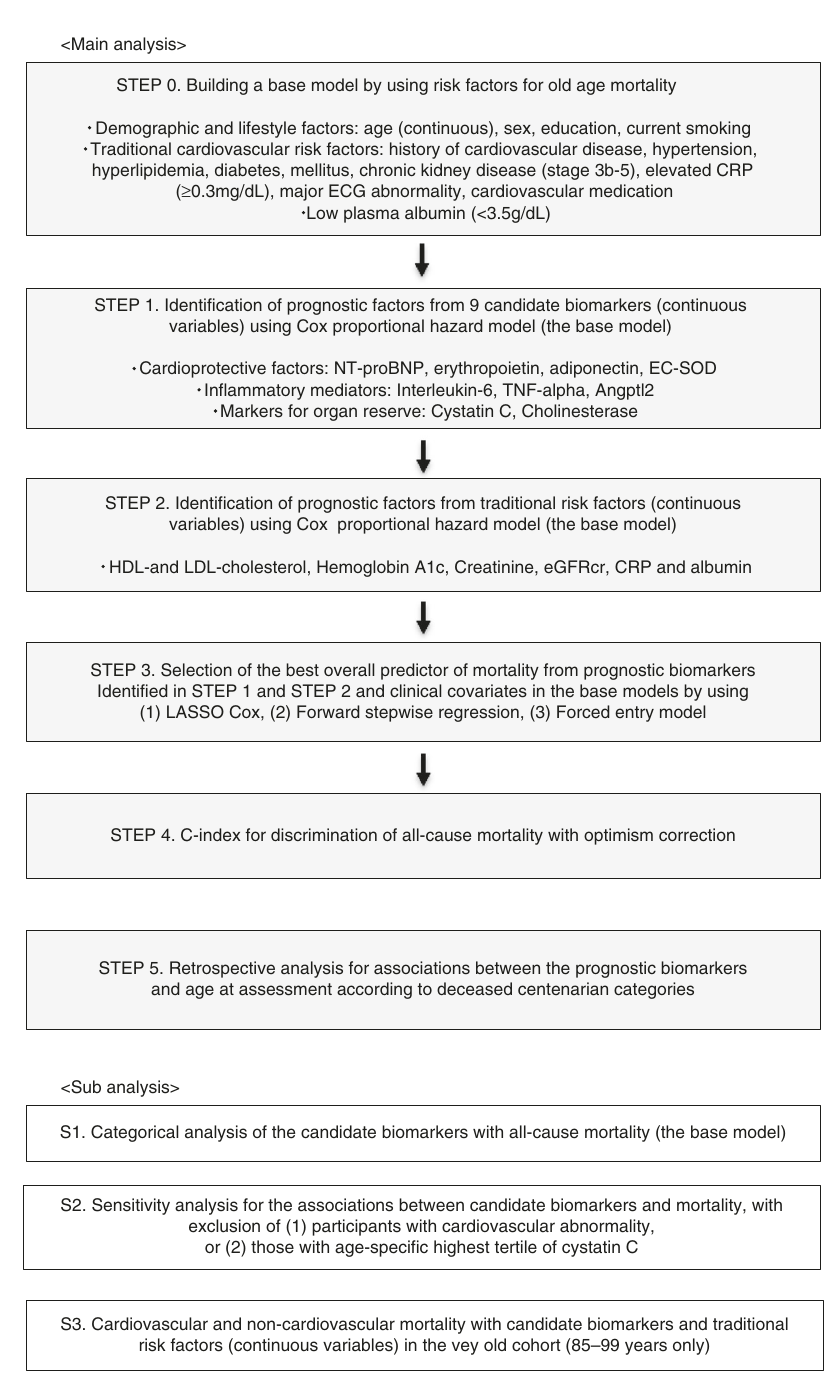
Fig. 3 Flowchart of statistical analysis to identify speci fi c biomarkers associated with exceptional survival. NT-proBNP N-terminal pro-brain natriuretic peptide, EC-SOD extracellular superoxide dismutase, TNF-alpha tumor necrosis factor-alpha, Angptl2 angiopoietin-like protein